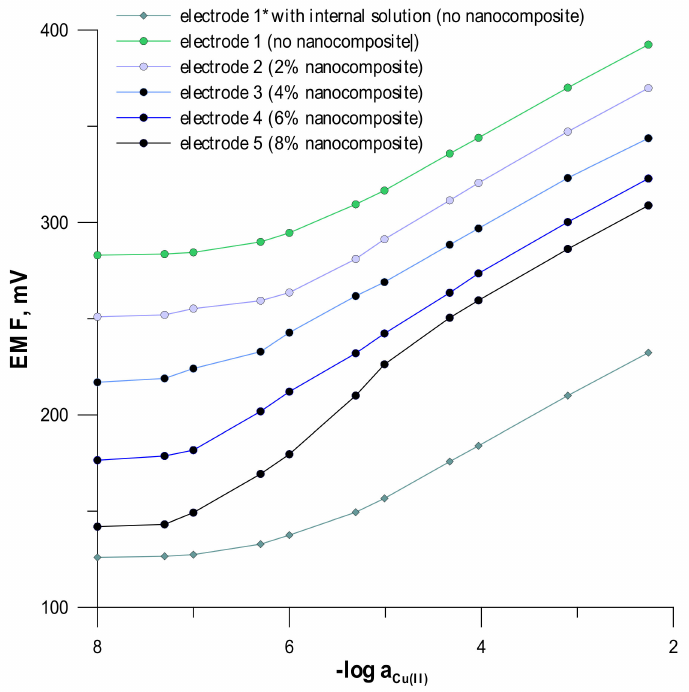
Figure 1. Calibration curves of studied